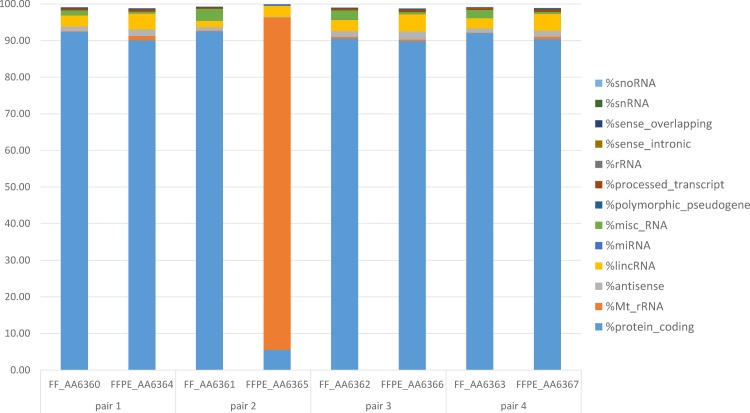
Annotated paired-end reads mapping to different gene biotypes.The majority of annotated reads mapped to protein-coding genes for all samples except FFPE_AA6365, which showed extremely high amounts of ribosomal MT RNA. The percentage of reads mapping to non-coding RNA was higher for FFPE than FF samples.